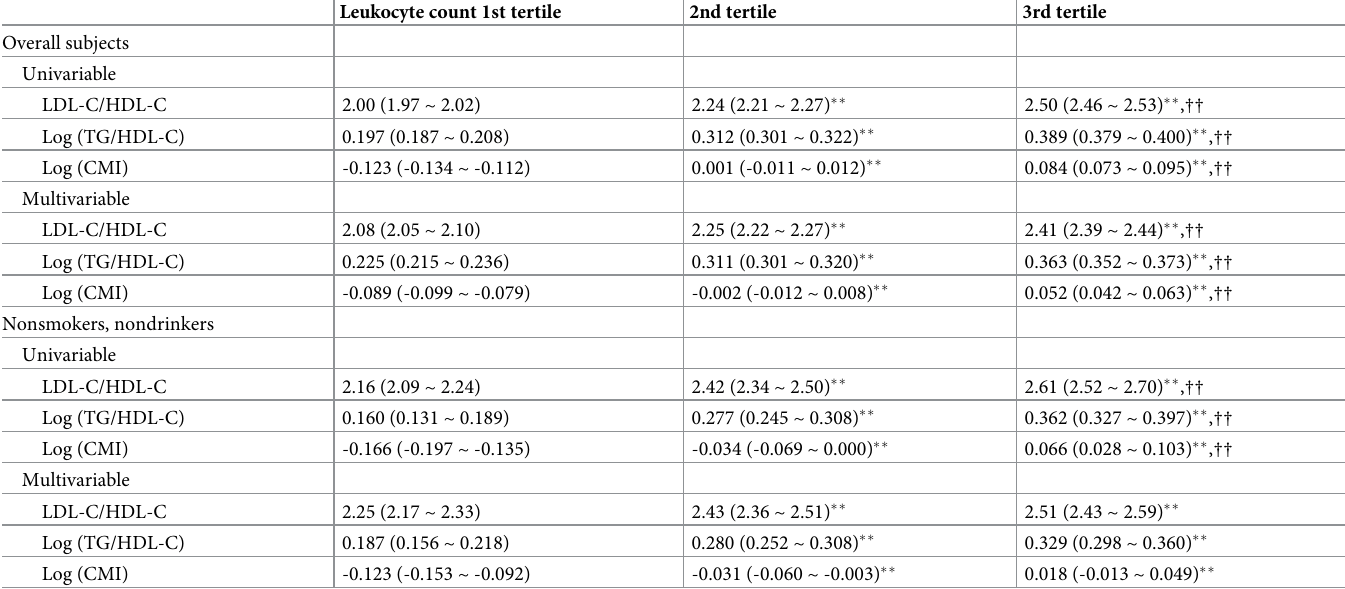
Table 4. Comparison of mean levels of each lipid-related index in the tertile groups of leukocyte count in overall subjects and subjects without habits of smoking and alcohol